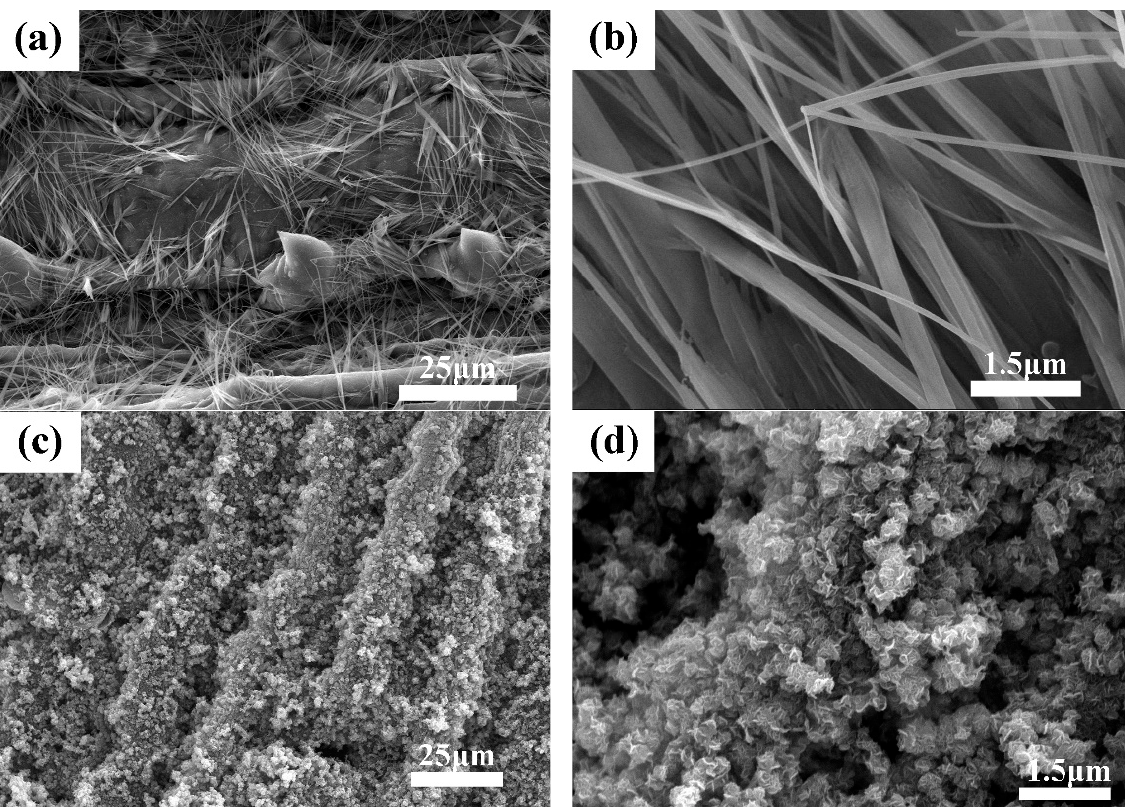
Figure 3. SEM images of MoS 2 /biocarbon obtained by DIC method ( a , b ) and by IHC method ( c , d ) under different magnification.